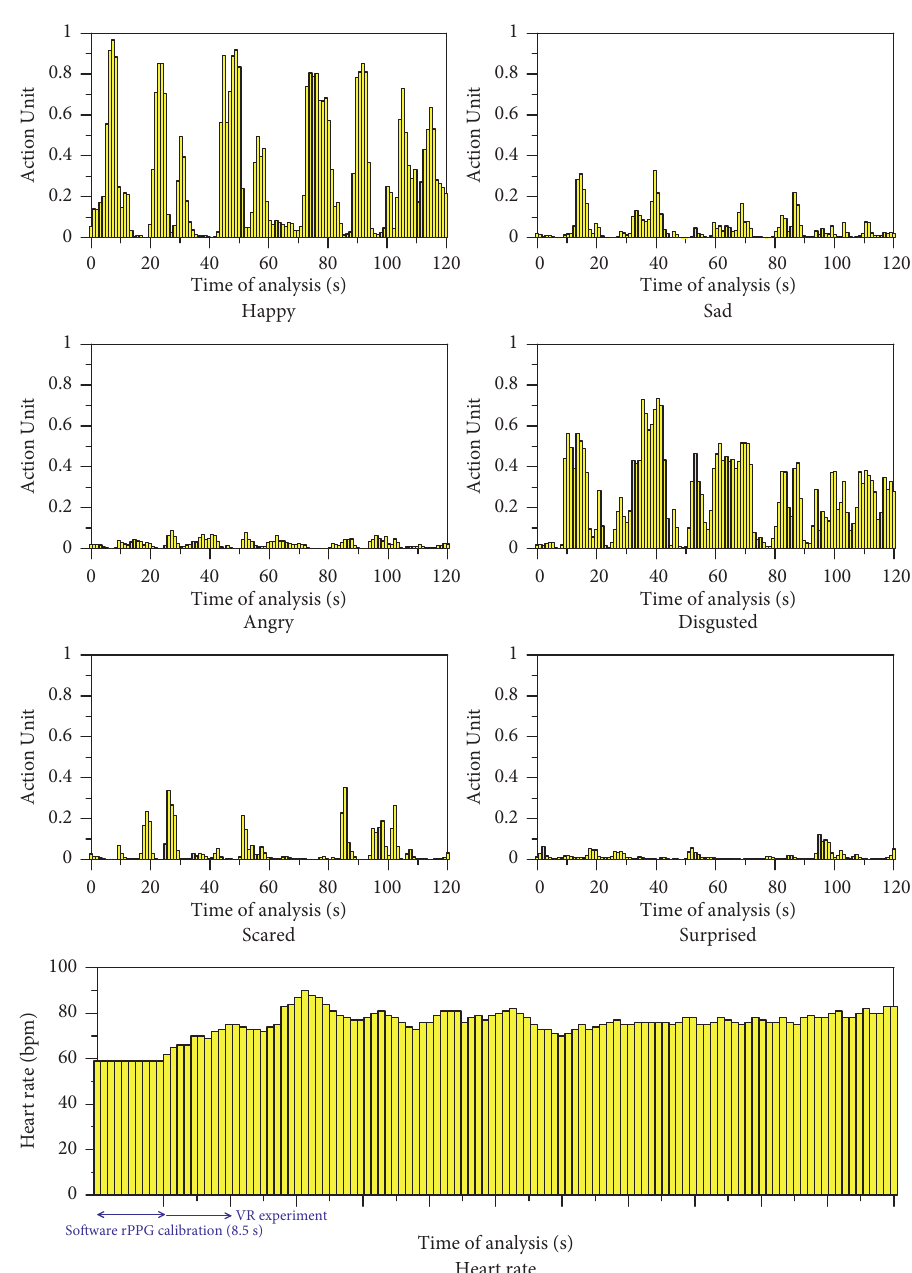
Figure 6: Example of AU (0–1 range) records of facial expressions and HR data (bmp), over the time of the experimental analysis, as obtained for one of the participants under VR